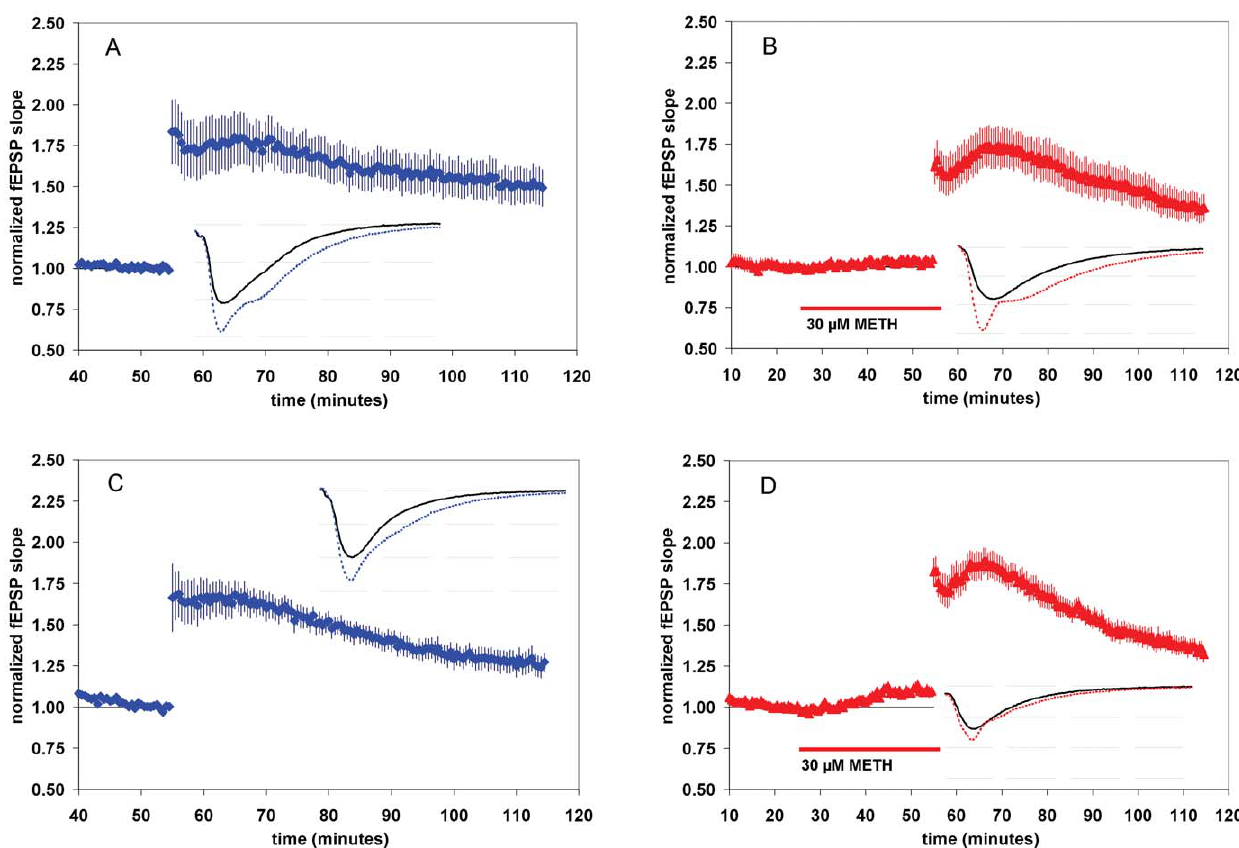
Figure 5. METH-induced increase in baseline synaptic transmission is attenuated in D1 receptor haploinsufficient mice. ( A,B ) Summary plot of normalized fEPSP slope measurements recorded in the CA1 region of the hippocampus of D1 + / 2 mice. The red triangles (B) are from METH (30 m M) treated slices; the blue diamonds (A) show results from drug-free experiments. Error bars are 6 SEM. Insets are 30-msec sweeps taken from representative experiments illustrating the average fEPSP 0–5 min prior to (solid line) and 55–60 min post-tetanus (dotted line, horizontal dashed lines are 1 mV apart). ( C,D ) Summary plot of normalizedfEPSP slope measurements recorded in the CA1 region of the hippocampus of D5 + / 2 mice.The red triangles (B) are from METH (30 m M) treated slices; the blue diamonds (A) show results from drug-free experiments. Error bars are 6 SEM. Insets are 30-msec sweeps taken from representative experiments illustrating the average fEPSP 0–5 min prior to (solid line) and 55–60 min post-tetanus (dotted line, horizontal dashed lines are 1 mV